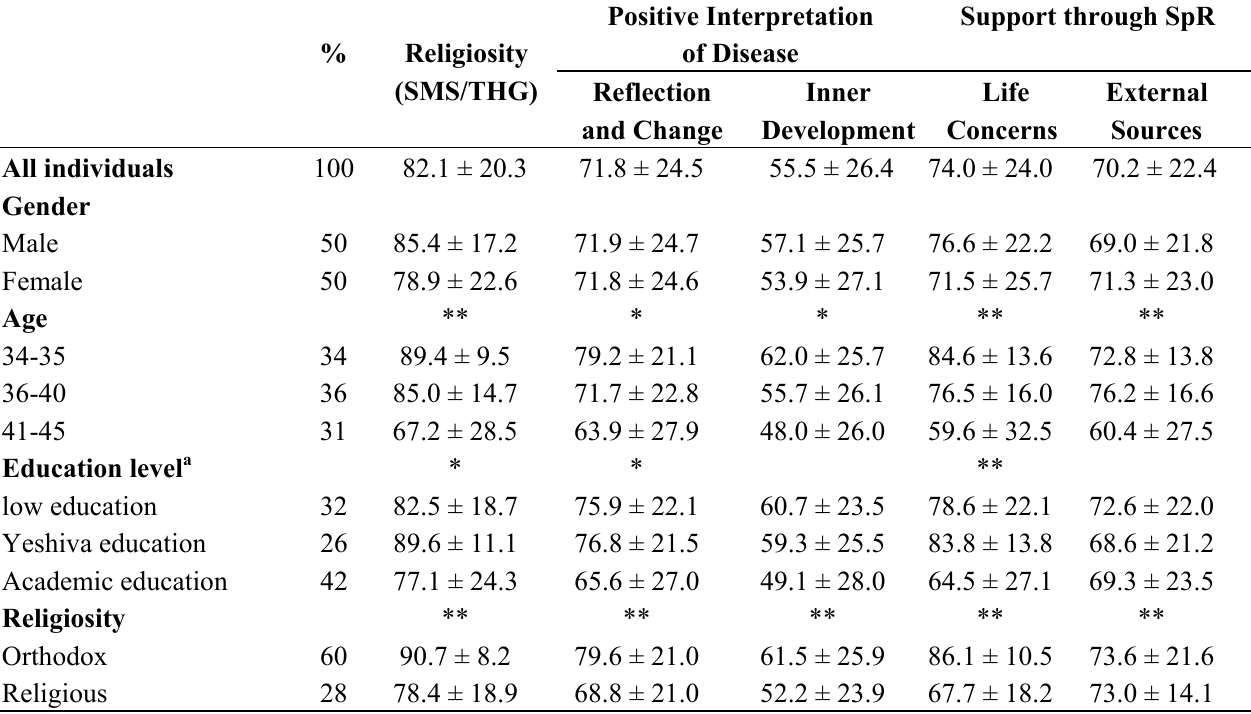
Table 5. Demographic and oral diseases data and SpREUK-Hebrew